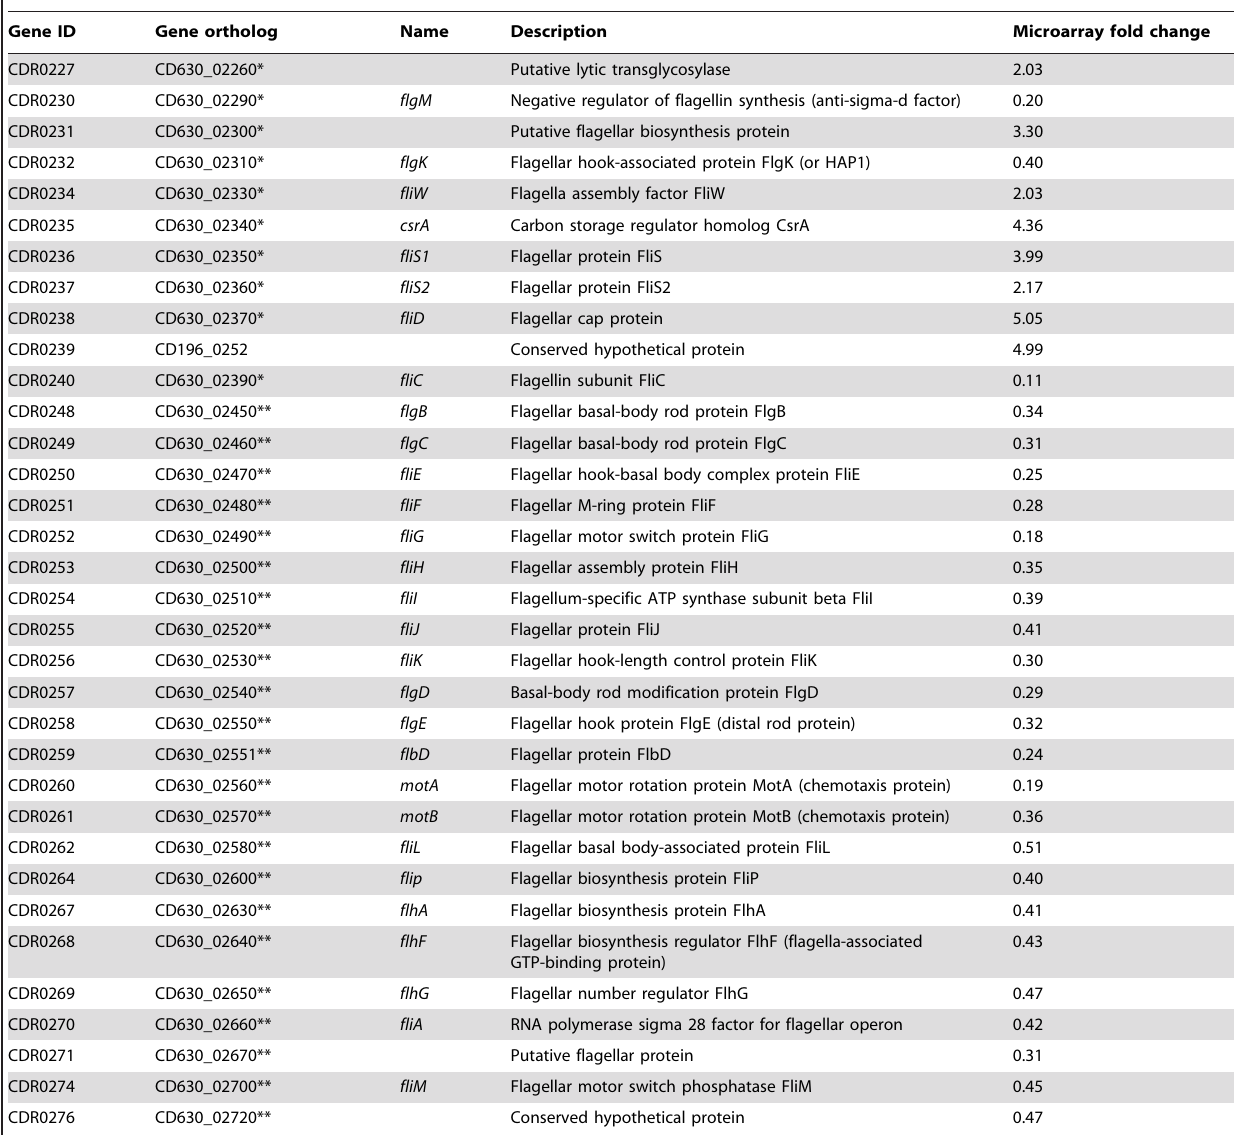
*From F1 region (late-stage flagellar genes) and **F3 region (early-stage flagellar genes) of the flagellar operon from C. difficile 630 [39].